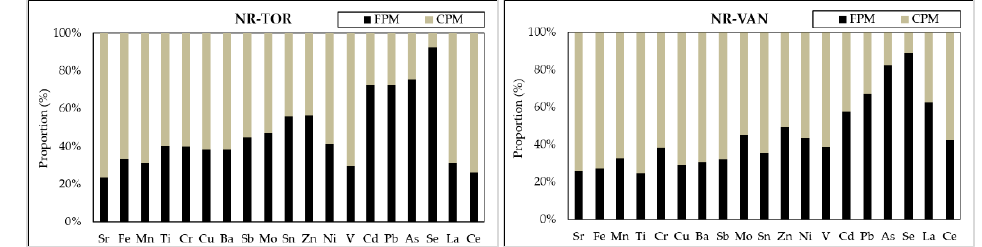
Figure 3. Relative contributions (%) of fine and coarse elements in PM 10 at the near-road sites. At the NR-TOR site, brake-wear-related elements (i.e., Ba, Cu, and Sb) are